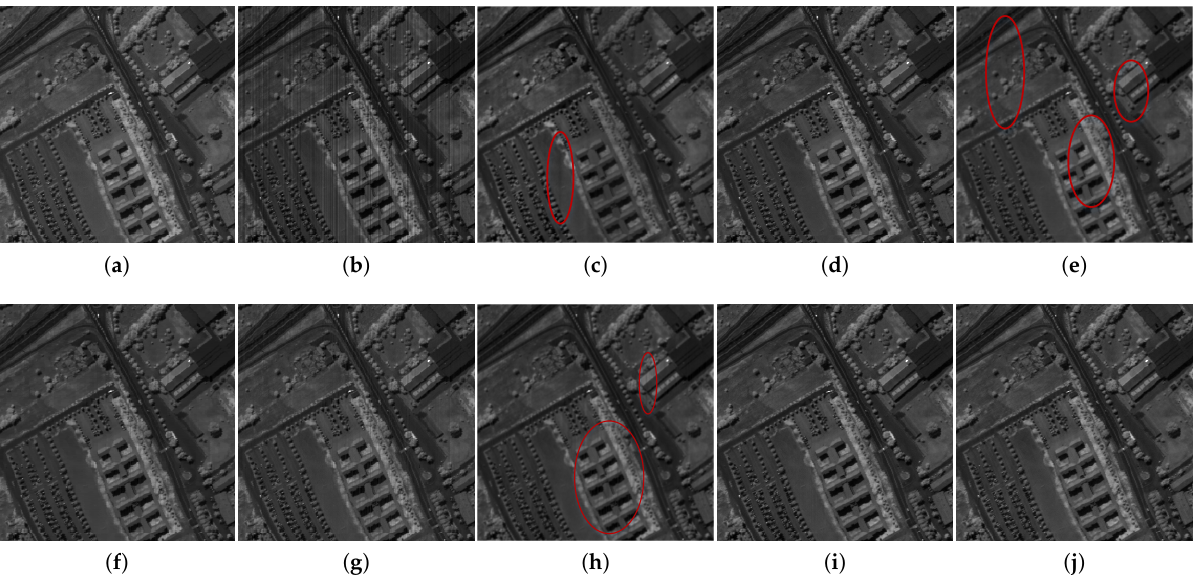
Figure 6. Corrected Pavia University images for band 99. ( a ) Original image. ( b ) Degraded image. Images corrected by ( c ) MM, ( d ) ASSTV, ( e ) LRSID, ( f ) that of reference [43], ( g ) PADMM, ( h ) ICSRN, ( i ) SSGN, ( j ) CSCNet.